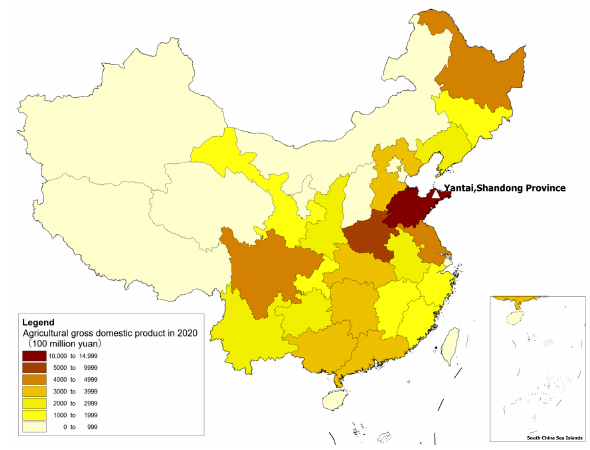
Figure 1. China’s agricultural development in 2020.